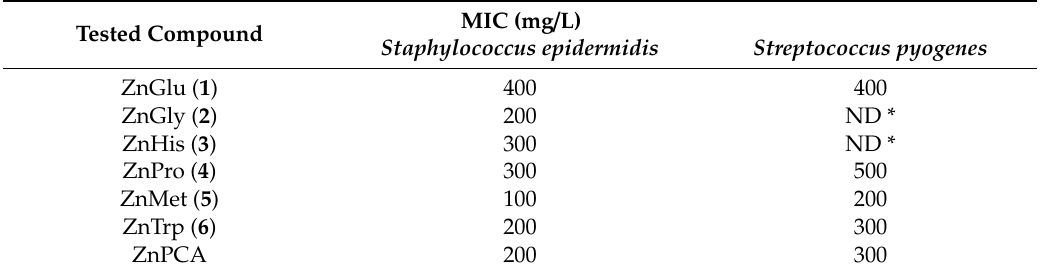
Table 6. Minimum inhibitory concentration (MIC) values of Zn(II) complexes for Gram-positive bacteria. Table6. Minimum inhibitory concentration(MIC) values of Zn(II) complexesfor Gram-positive bacteria.